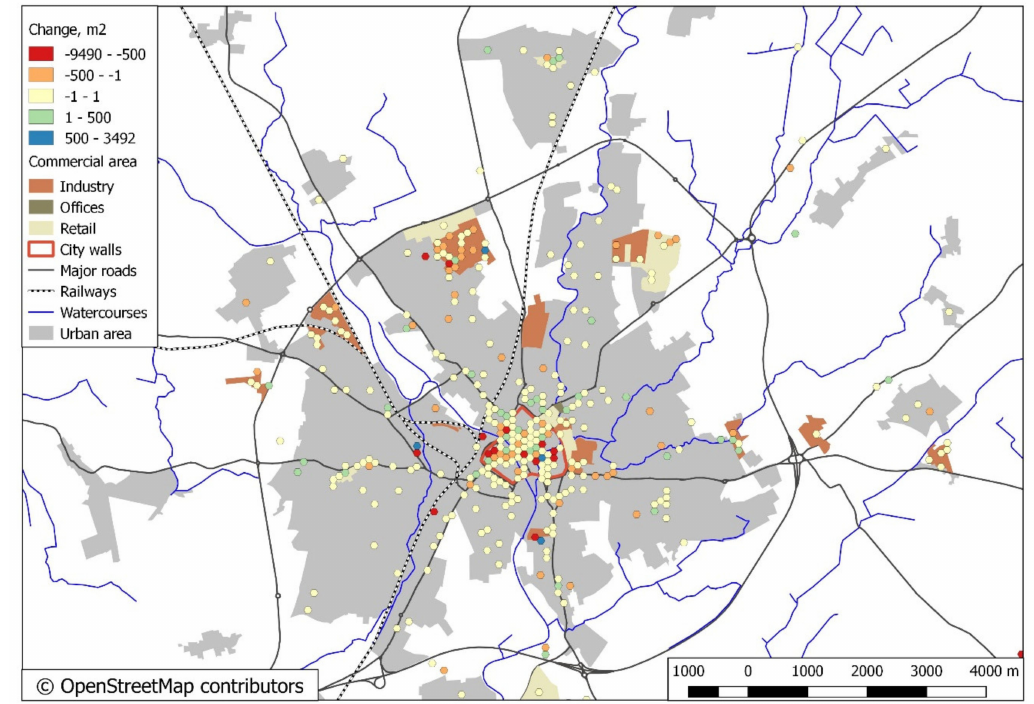
Figure 10. Change in o ffi ce property floorspace distribution,